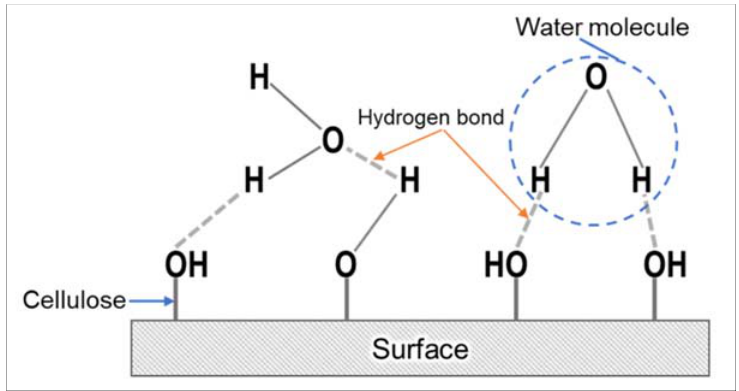
Figure 4. Diffusion of water molecules into CR fiber ‐ reinforced MWCNT ‐ phenolic composites.